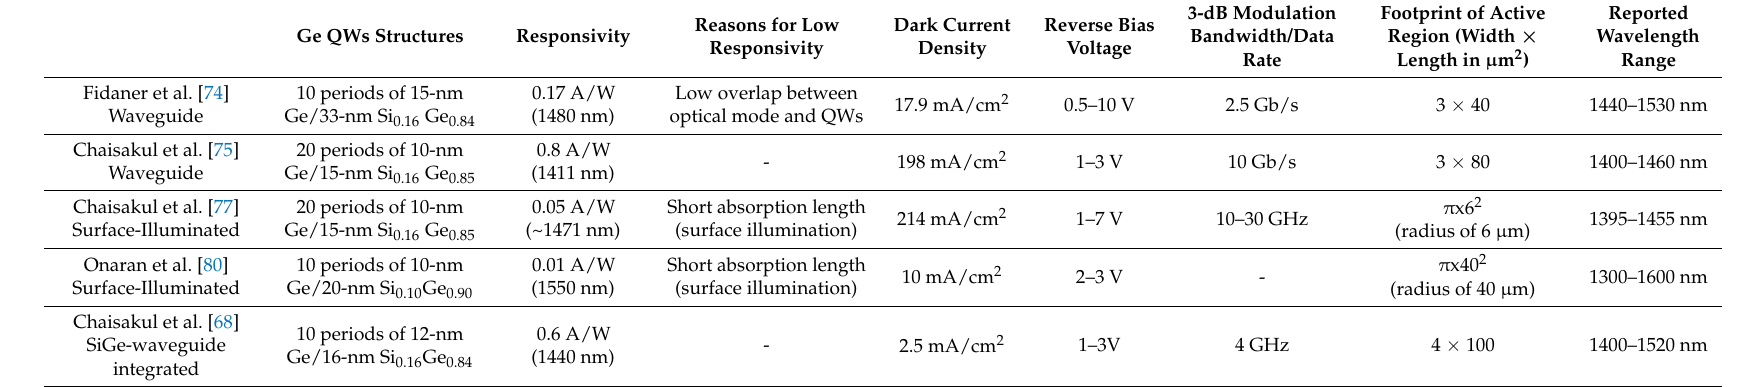
Table 2. Summary of performance matrix obtained from Ge/SiGe MQW optical detectors experimentally